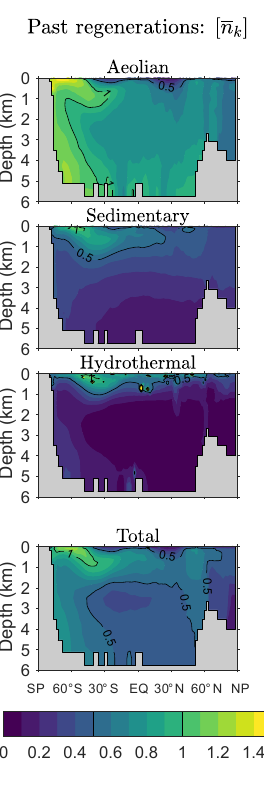
Figure 6. Zonal averages of the mean number of past passages through the biological pump (i.e., since birth), n k . This figure is for our typical